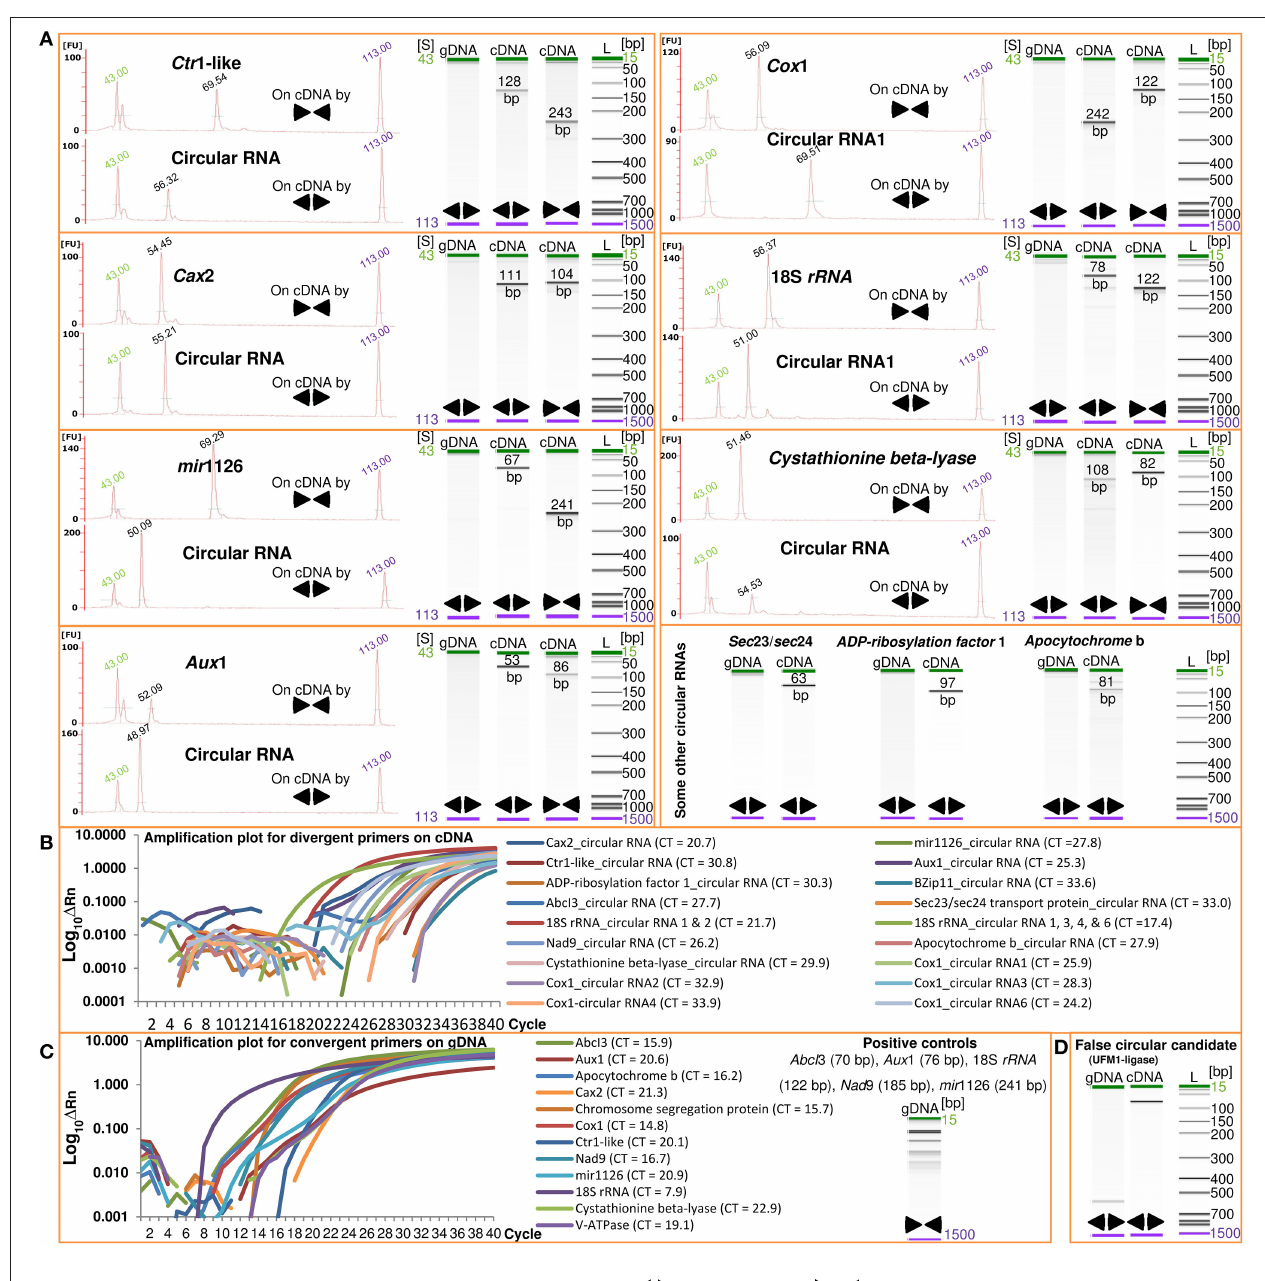
FIGURE 1 | Analysis of barley circular RNAs. Real-time PCR using divergent ( ) and convergent ( ) primers and subsequent amplicon-size analysis on Agilent Bioanalyzer were used to confirm the identified barley circular RNAs. The absence of genomic DNA fragments corresponding to the junctions of 26 selected circular RNAs ( A and Supplementary File 1) as well as the detection of 21 examined circular RNAs at transcript level ( B and Supplementary File 1) validate the existence of circular RNAs in both barley leaves and seeds. The real-time PCR reactions were further analyzed by Agilent Bioanalyzer which confirmed the amplicons at the expected sizes shown as electropherograms and gel electrophoresis runs (A) . We also used the convergent primers of parental genes as positive controls for the genomic DNA (C) . The false positive circular RNA of the gene UFM1-ligase was included in the analysis as a negative control (D) . FU and S represent fluorescence absorbance and time of electrophoresis of the PCR reactions in Agilent Bioanalyzer. The electrophoresis time (in seconds) are shown on top of the electropherogram peaks as well as the lower and upper marker peaks. The labels of cDNA and gDNA indicate the type of template used in the real-time PCR reactions. Amplification plots for the divergent primers on gDNA indicating no amplification and for the divergent and convergent primers across all cDNA samples are shown in Supplementary File 1. See Table 1 for full name of the genes. Bp, base pair; CT, the cycle threshold of amplified fragments; 1 Rn, the normalized fluorescence of the reporter dye minus baseline in real-time PCR; L,